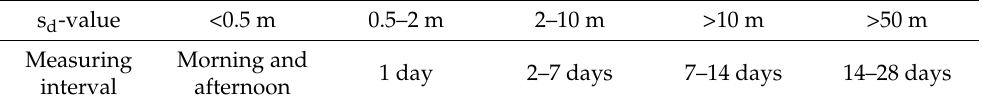
Figure 3. Prepared sample container, with the diameters of the sample and of its exposed area illustrated. The sample is circular. Table 2. Measuring Intervals Depending on the Vapour Permeability of the